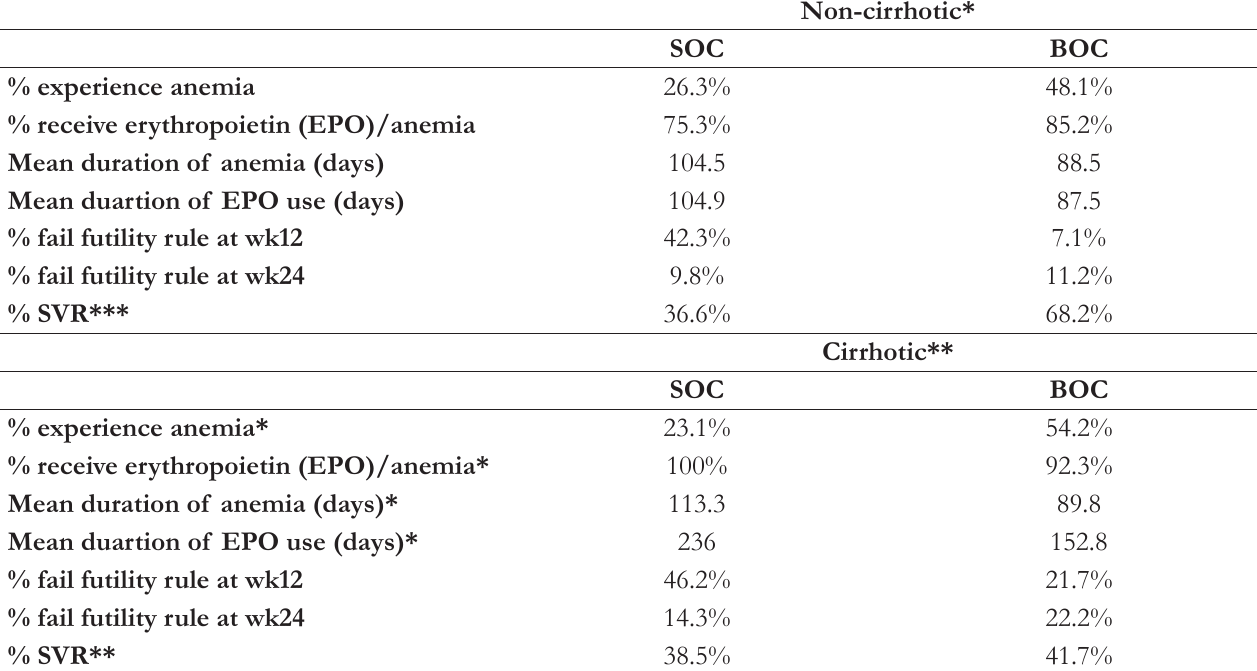
Table 2. Treatment Outcomes in Treatment-naive Patients